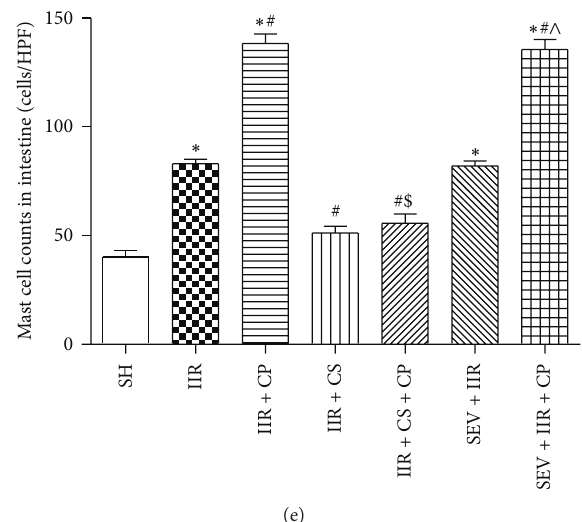
Figure 3: Tryptase protein expression in intestine mucosa, and 𝛽 -hexosaminidase levels in serum, intestinal mast cell counts after IIR injury. SH group (Sham-operated group), IIR group (75min intestinal ischemia and 2 h reperfusion), IIR + CP group (IIR group + Compound 48/80 1mg/kg), IIR + CS group (50mg/kg cromolyn sodium treated IIR group), IIR + CS + CP group (50mg/kg cromolyn sodium treated IIR group + Compound 48/80 1mg/kg), SEV + IIR group (2.3% sevoflurane pretreated IIR group), and SEV + IIR + CP group (2.3% sevoflurane pretreated IIR group + Compound 48/80 1mg/kg). Representative band of tryptase protein expression in intestinal mucosa is displayed in (a). Bar graphs (b) quantified tryptase protein expression ( 𝑛 = 3 ). Bar graph (c) quantified 𝛽 -hexosaminidase levels ( 𝑛 = 6 ). Representative images of immunohistochemical staining for tryptase in intestine are displayed in (d) (SP staining, × 200); brown-yellow granules in the cytoplasm were recognized as mast cells. Bar graph in (e) quantified mast cell counts in small intestine ( 𝑛 = 6 ). Results are expressed as Mean ± SEM. ∗ 𝑃 < 0.05 versus SH group, # 𝑃 < 0.05 versus IIR group, $ 𝑃 < 0.05 versus IIR + CP group, & 𝑃 < 0.05 versus IIR + CS group, and ∧ 𝑃 < 0.05 versus SEV + IIR